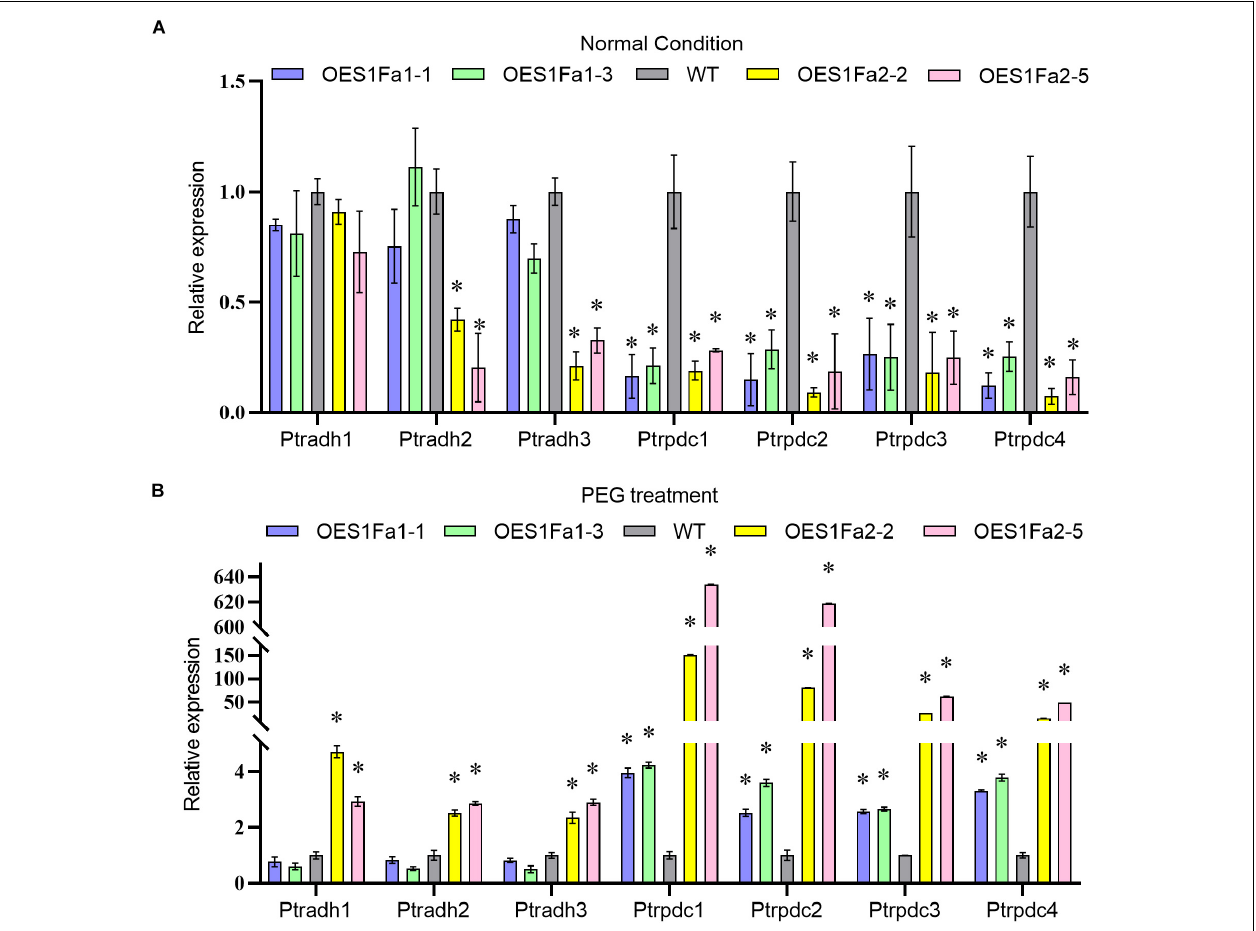
FIGURE 9 | Analysis of the expression of hypoxia genes regulated by PtS1Fa1 and PtS1Fa2 . Analysis of hypoxia gene expression in OEPtS1Fa1, OEPtS1Fa2 and WT plants under normal (A) or PEG treatment conditions (B) . Plants are treated with 20% (w/v) PEG6000 for 9 h, and were used for qRT-PCR. Error bars represent the standard deviation (STD) of three biological replicates. The asterisk indicates significant difference between the genetically modified strain and WT ( P > 0.05).